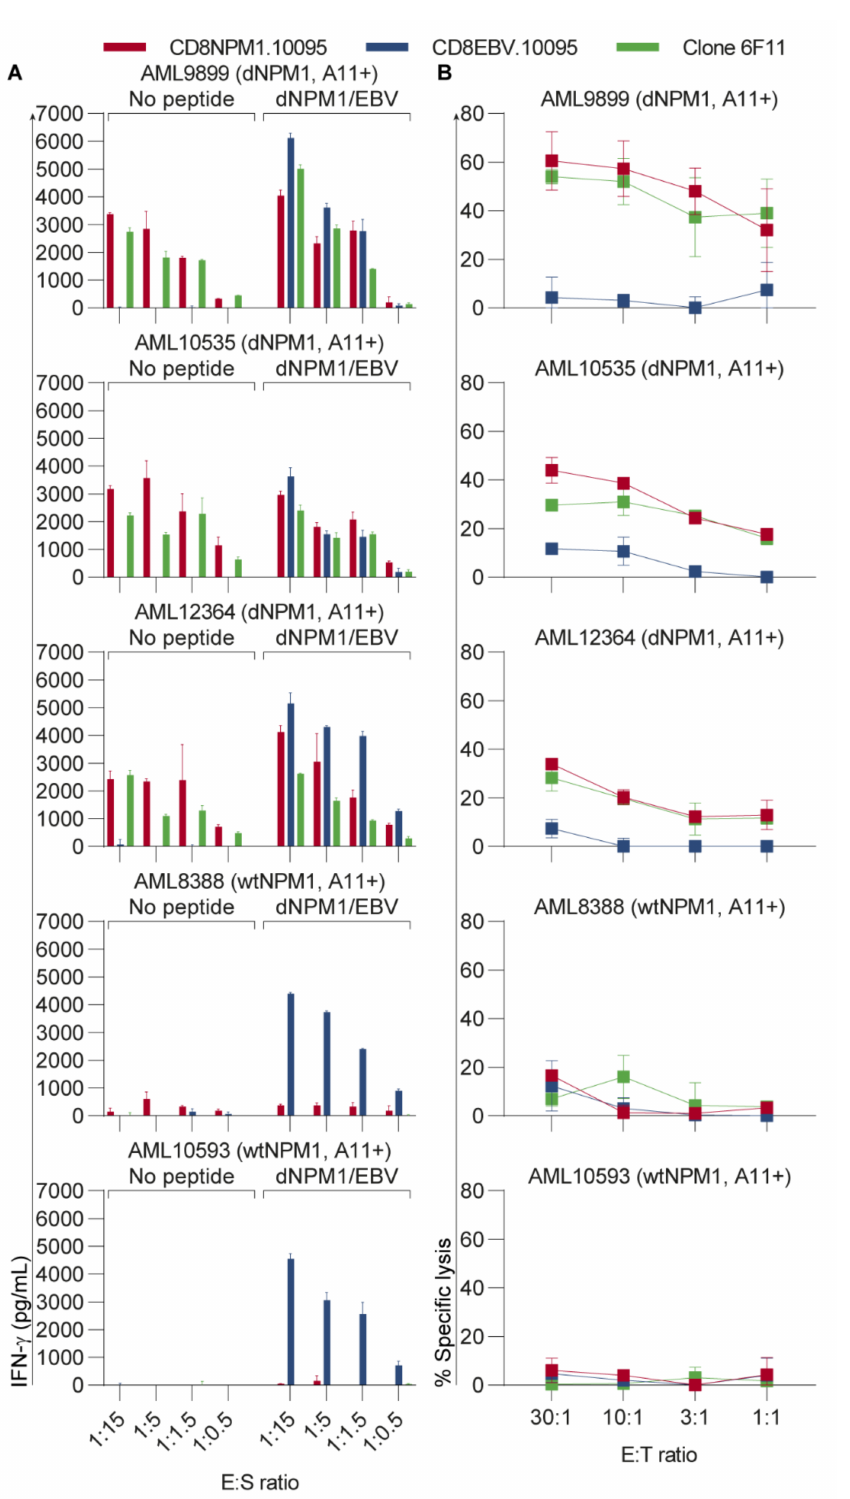
Figure 3. The HLA-A11-restricted dNPM1 TCR targets primary AML. CD8 T-cells transduced